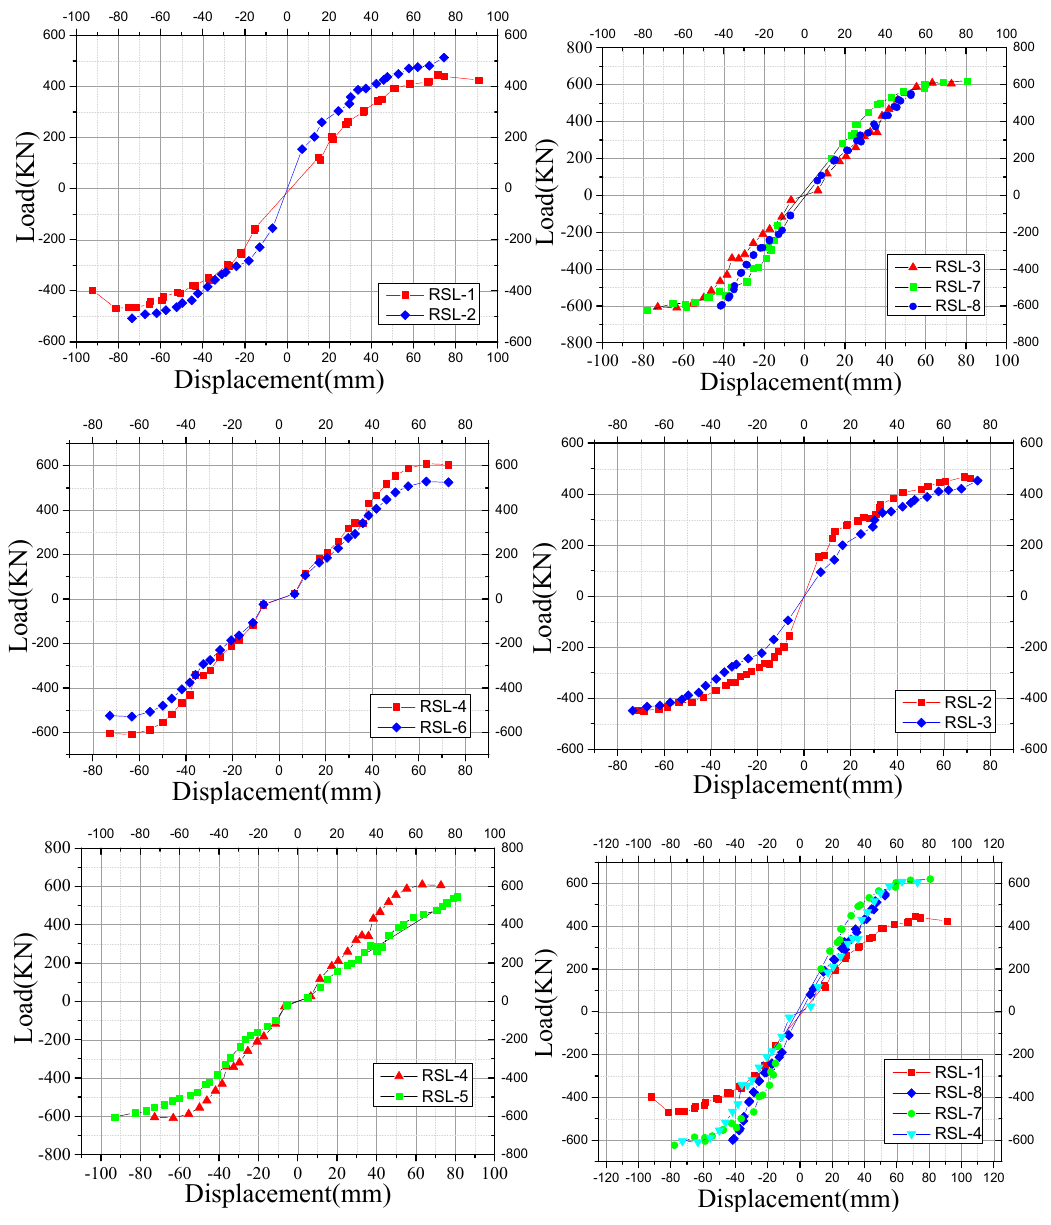
Figure 13. Skeleton curves of specimens.